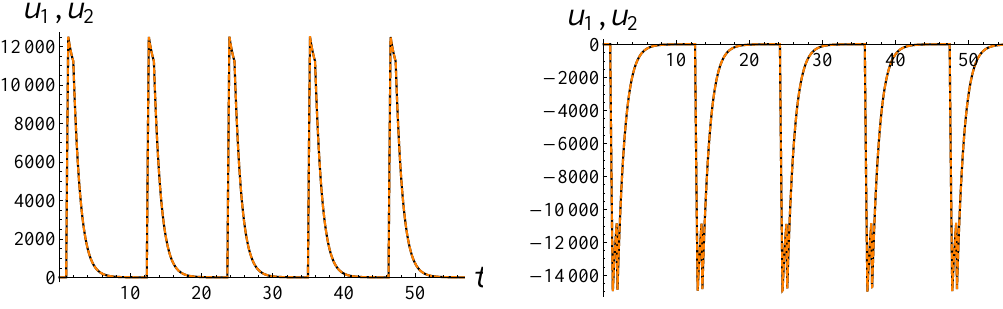
Figure 3. Two coexisting relaxation cycles of the system (3). Values of parameters: T = 1, γ = 0.4, p = 1, λ = 10,000. Black line— u 1 ( t ) , orange dashed line— u 2 ( t )